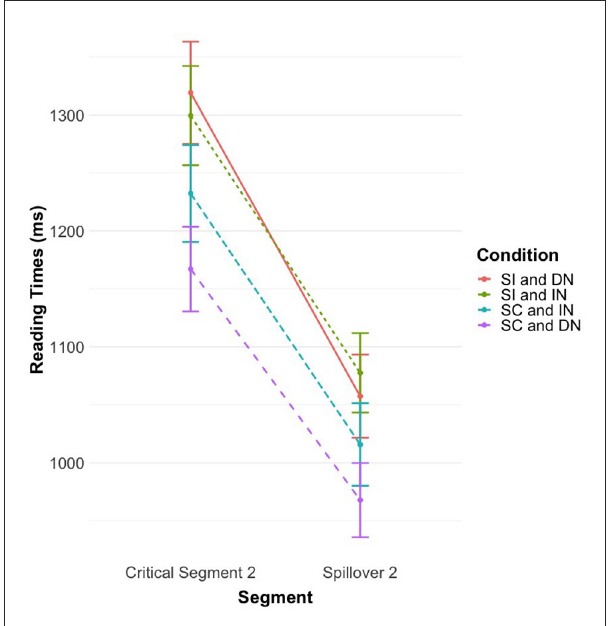
FIGURE2 Mean reading times in milliseconds for Experiment 2 (second critical segment and spillover). Mean and standard error reading times (raw data) in Experiment 2 for the second critical segment and its spillover. SC, stereotype-congruent; SI, stereotype-incongruent; DN, definite NP; IN, indefinite